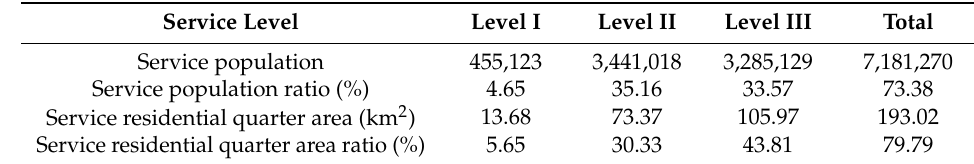
Table 3. Statistical table of greenway service